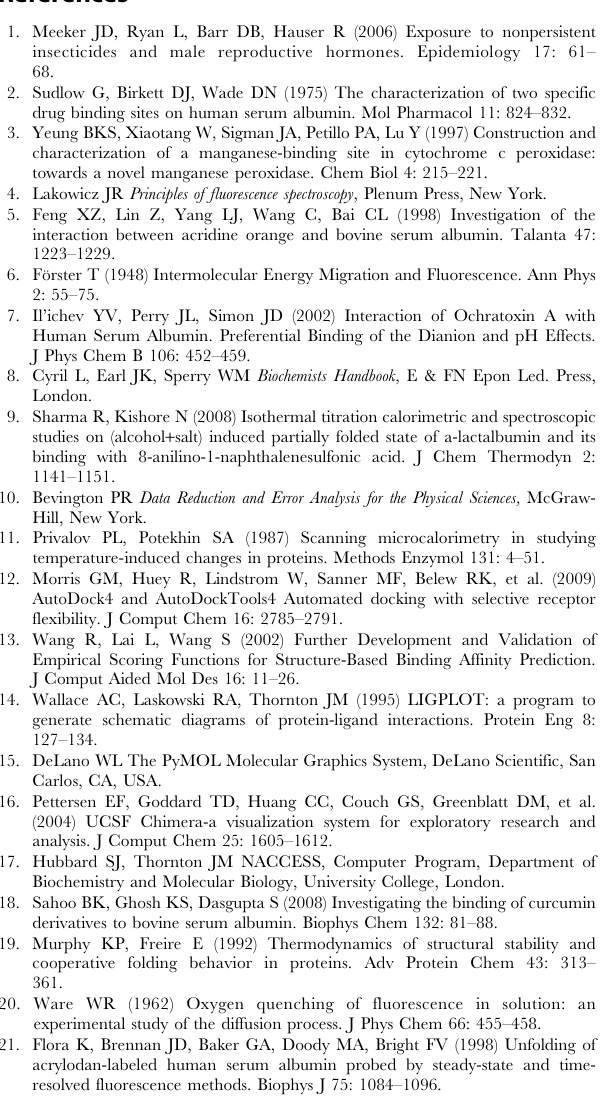
Table S2 Interaction profile of pollutants with HSA after rigid docking with Autodock where number of contacts for corresponding residues to the ligand are given in parentheses and residues corresponding to D ASA . 10 A˚ 2 are in